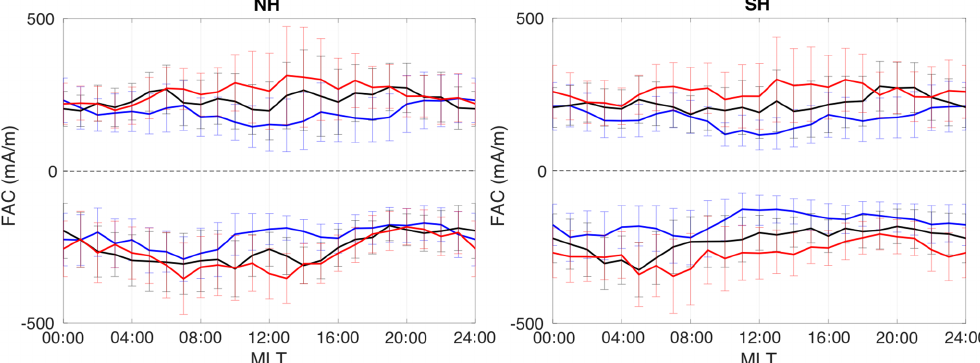
Figure 2. Diurnal variation of averaged FACs in 1h local time bins for different seasons. The left (right) panels are for Northern (Southern) Hemisphere. The blue, black, and red lines represent local winter, equinox, and summer, respectively. Presented are the summed upward and downward FAC sheet current densities in each hour